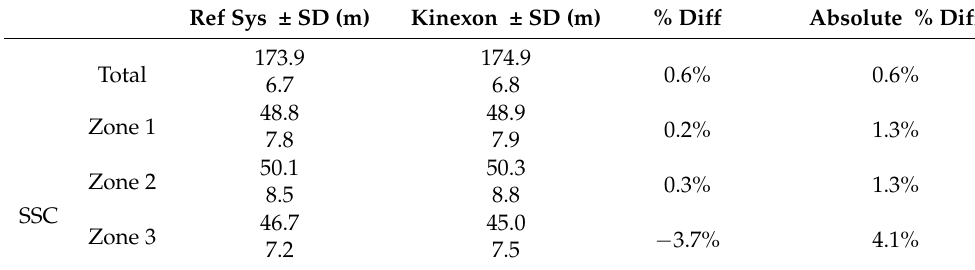
Table 6. Covered distance in SSCs and SSGs, shown in five speed zones and the total trial. In SSGs, zone 4 was only reached in two occasions and is therefore excluded. No player reached speed zone 5 in all